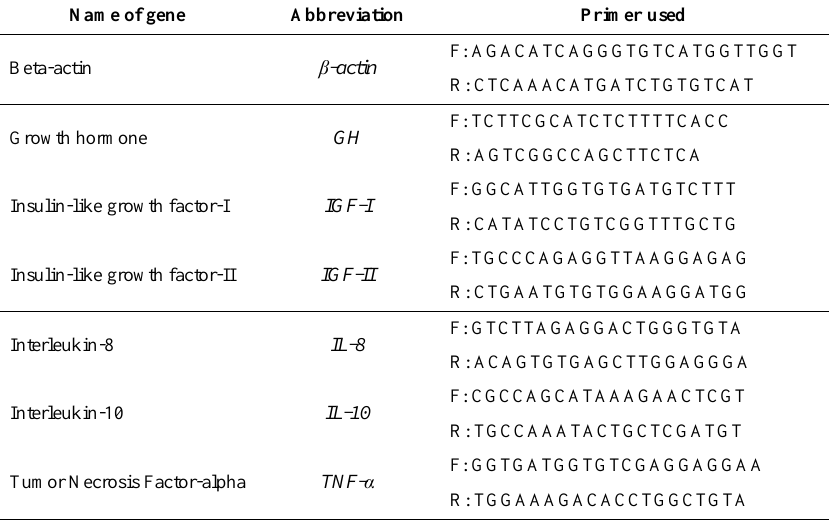
Table 2. Oligonucleotide primer sequences used in RT-PCR for gene expression analysis